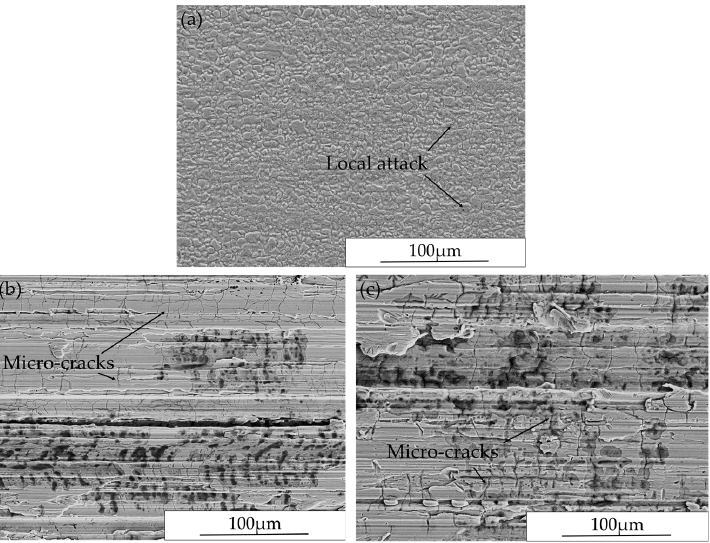
Figure 6. Surface morphology after exposure without external loading of: ( a ) AD specimen; ( b ) Ground-RD specimen; and ( c ) Ground-TD specimen.